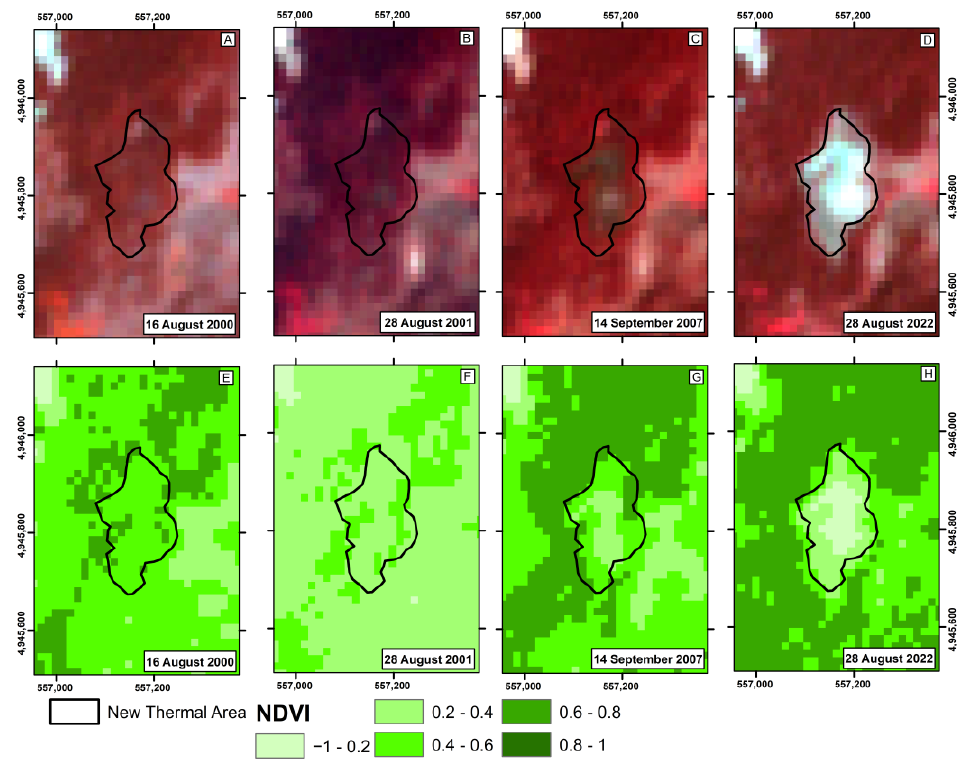
Figure 9. Yellowstone new thermal anomaly near Tern Lake: the ASTER RGB composite image (bands 3, 2, 1) and the NDVI map, respectively, for the following dates: 16 August 2000 ( A , E ); 28 August 2001 ( B , F ); 14 September 2007 ( C , G ); 28 August 2022 ( D , H ). The black line corresponds to the new thermal anomaly area.